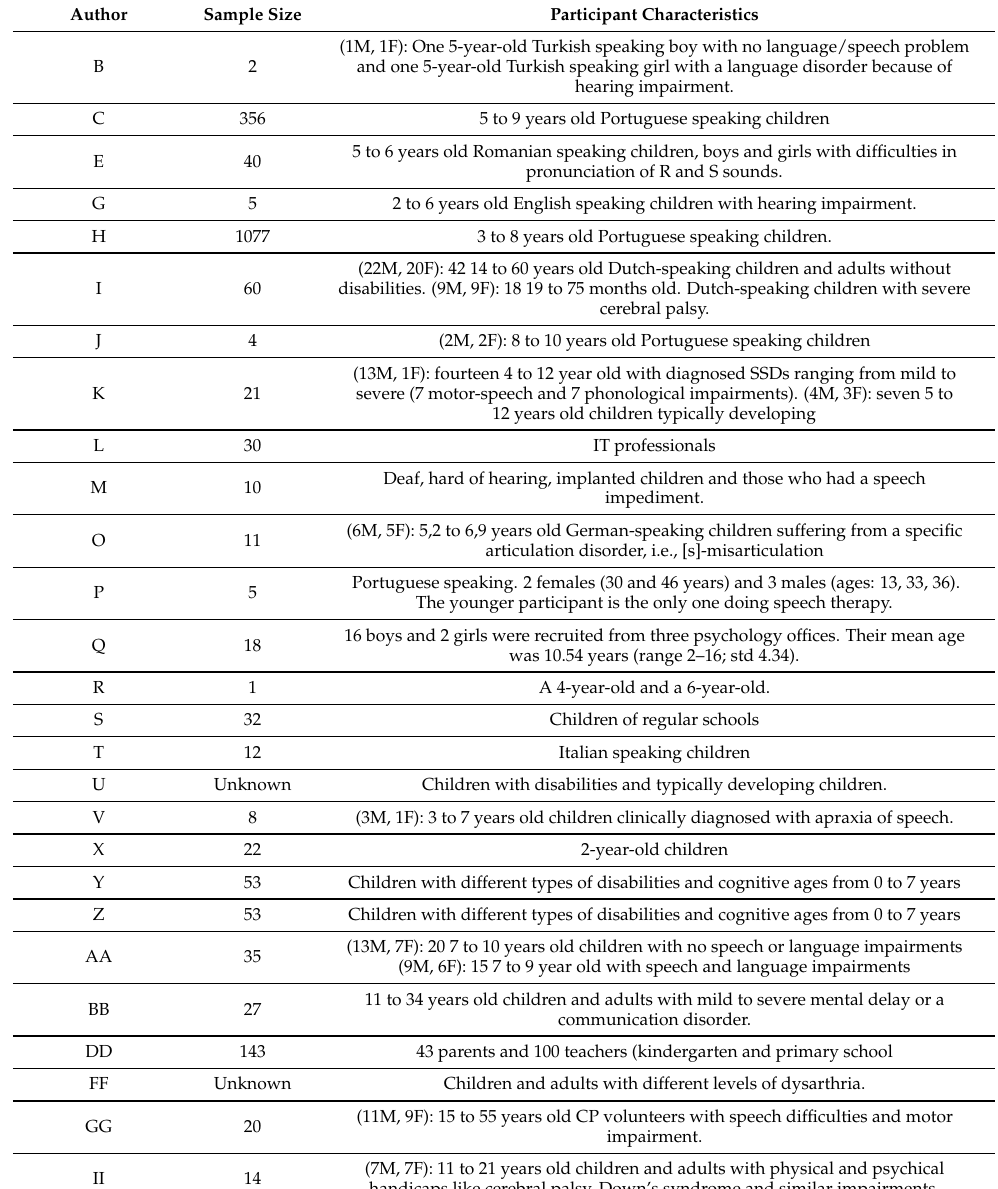
Table A3. Sample size characteristics of experimental